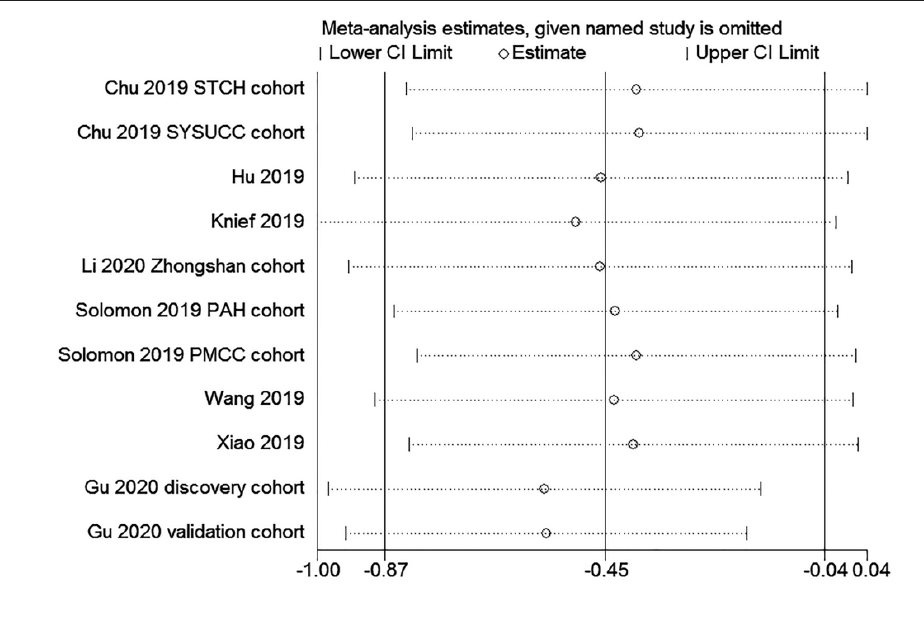
Fig. 5. Influence analysis mentioned in the text.